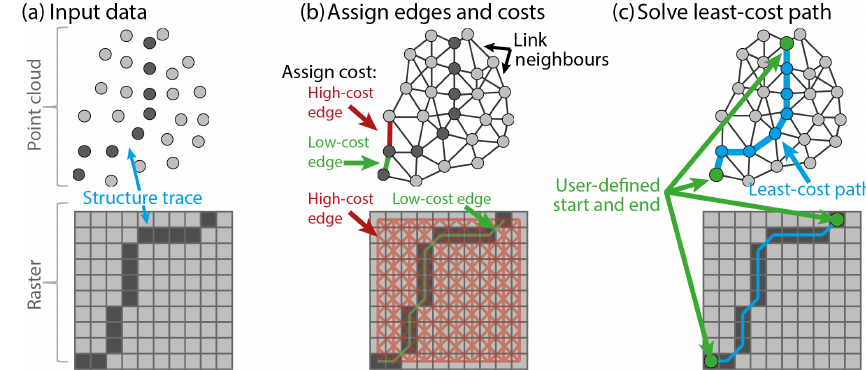
Figure 1. Schematic representation of the least-cost-path approach to trace detection for point cloud (top) and raster (bottom) data. Points and pixels on the structural trace have a lower brightness in this example (a) , so a brightness-based cost function will result in low-cost edges between adjacent points and pixels that both fall on the structure trace (b) . A least-cost-path calculation (c) then provides an estimate of the structure